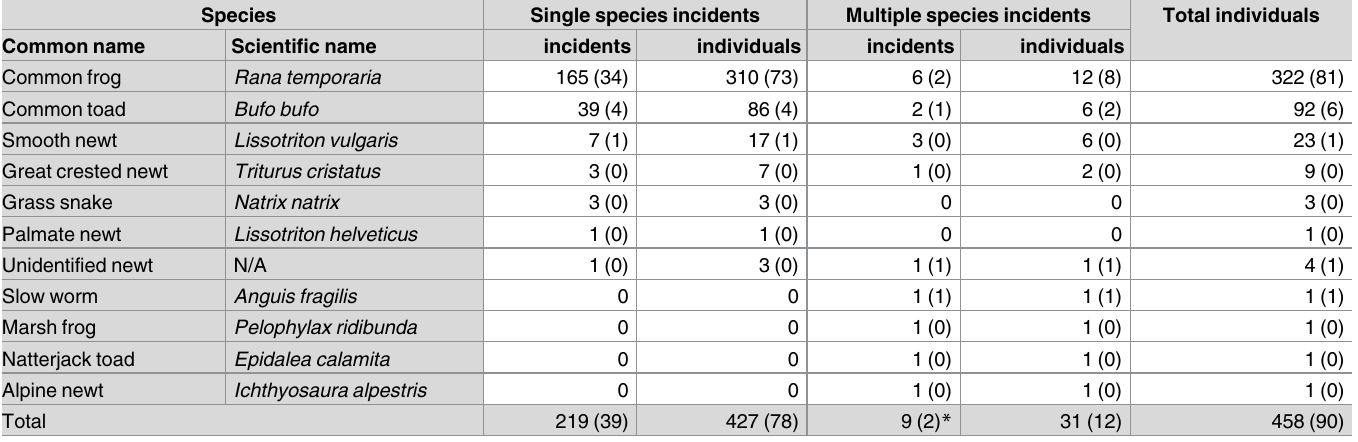
Table 1. Sampling and results of ranavirustesting in the British Isles from 1992to 2016 inclusive. The sample and results are summarisedby species and by incidentand split into incidentsfrom which either single or multiplespecies were submitted and tissues were available for testing. The number of rana- virus positives(definedby positive results from both qPCR and conventional PCR assays) are given in parentheses.